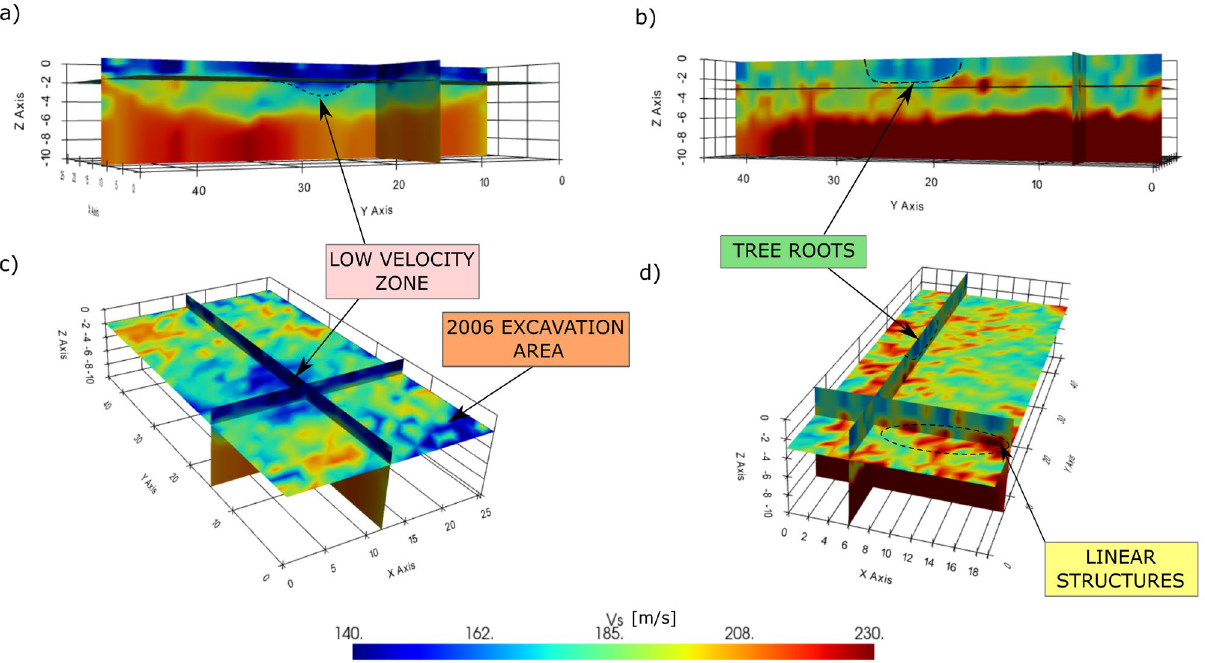
Figure 4. Quasi-3D V s model obtained through depth inversion of local dispersion curves in grid 1 (left) and grid 2 (right). ( a , b ) View from East. ( c , d ) View from South with 30 degrees